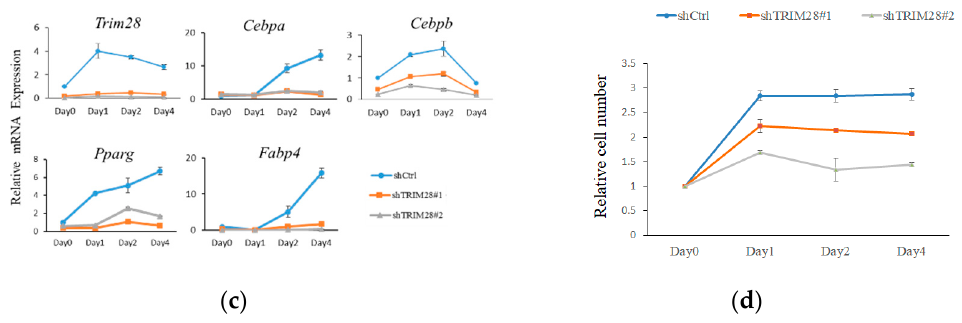
Figure 1. Trim28 is required for differentiation of 3T3-L1 preadipocytes. ( a ) Protein and mRNA expression of Trim28 in knockdown 3T3-L1 preadipocytes. 3T3-L1 cells were transduced with lentiviral-carrying shRNA against Trim28 (shTrim28#1 and shTrim28#2) and a non-specific control (shCtrl). ( b ) The oil red O staining of control and Trim28 KD 3T3-L1 after FDMI (FBS, DEX, MIX and Insulin) treatment for differentiation of eight days. ( c ) mRNA expression of adipogenesis markers in Trim28 KD cells during treated with FDMI for zero, one, two, and four days. ( d ) 3T3-L1 cells treated with FDMI for zero, one, two, and four days. The cells were stained with trypan blue and the cell numbers were calculated by automated cell counter. The relative cell number was normalized with control cells at 0 day. *** p < 0.001, ** p < 0.01, * p < 0.05.